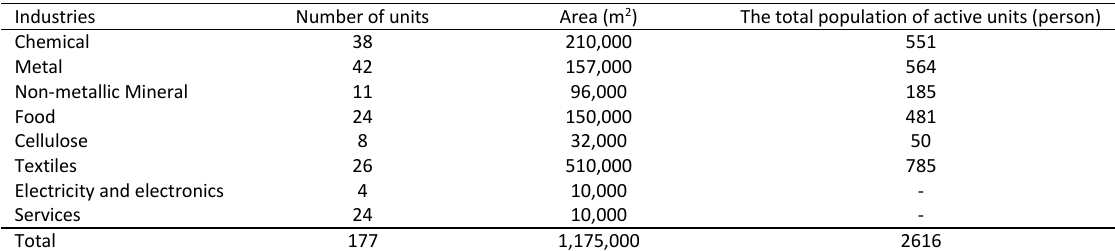
Table 1: Specifications of each industrial unit in Brujen industrial park